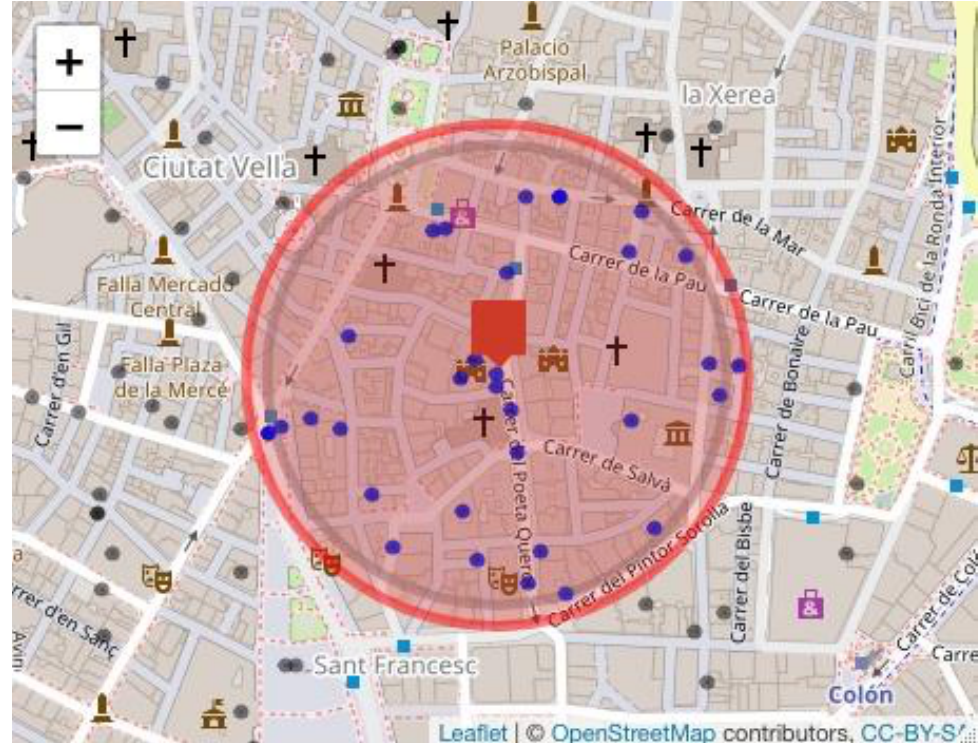
Figure 4. The highest risk cluster considering the original risk centroid (gray circle, radius = 200 m) and expanding the radius by 20 m (red circle, margin = 20 m). Haversine distance is used. Interactive map available at: https://go.uv.es/vcoll/cumulus_3 (accessed on 31 May 2021).